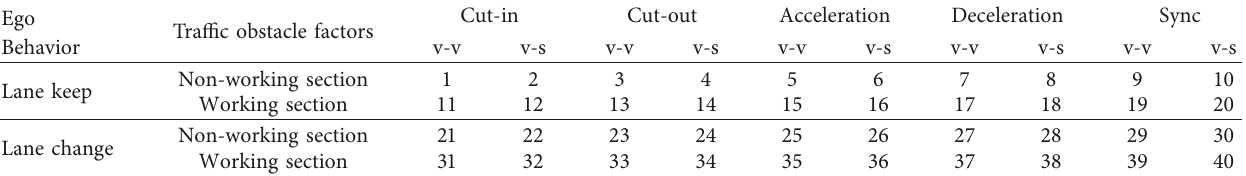
Table 3: Typical traffic accident classification.